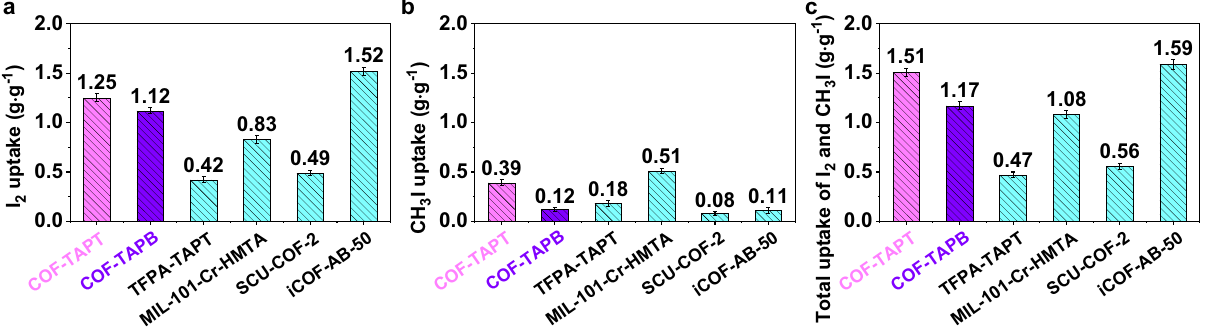
Fig. 5 Comparison of different adsorbents in dynamic adsorption capacity. The capacities were measured from a single-component I 2 at 150 ppm, b single-component CH 3 I at 50 ppm, c mixed-component (150 ppm I 2 and 50 ppm CH 3 I) breakthrough experiments performed at 25 °C. The error bars are the standard deviations from three parallel